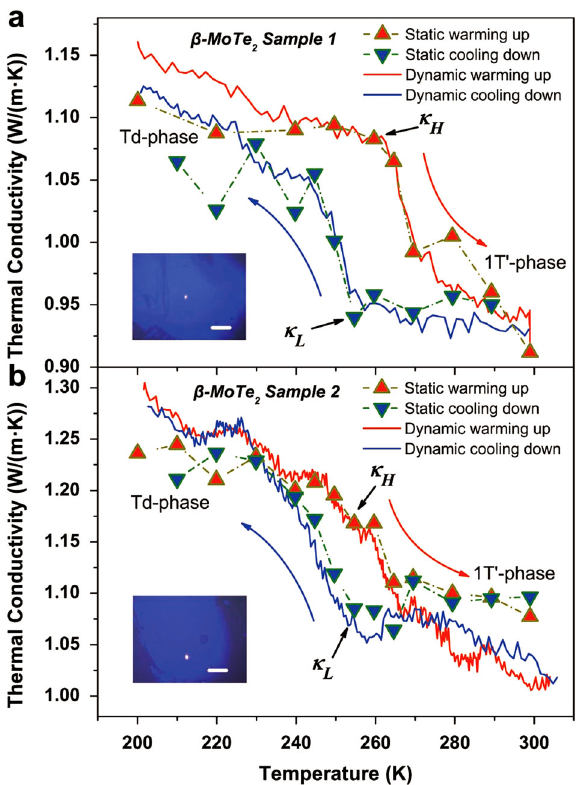
Fig. 3 a & b Hysteretic behaviors of c -axis thermal conductivity in the metastable phase MoTe 2 sample 1 & 2. The triangular scatters represent the experimental data measured by ‘ the static method ’ , while the solid lines represent the results continuously measured by ‘ the dynamic method ’ . The red and blue arrows indicate the directions of warming up and cooling down routes, respectively. The inserted images show the locations of focused laser spots on the MoTe 2 samples during the TDTR higher one κ H and the lower one κ L in the warming up and cooling down routes, respectively. This is so-called thermal hysteresis of thermal conductivity, where values cannot recover in the opposite temperature evolution and a hysteresis loop is formed around